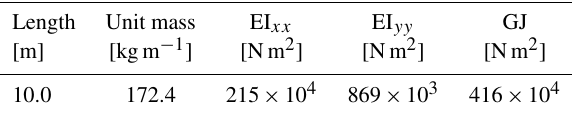
Table 2. Straight-beam geometry and cross-section stiffness prop- erties. Beam is clamped from its